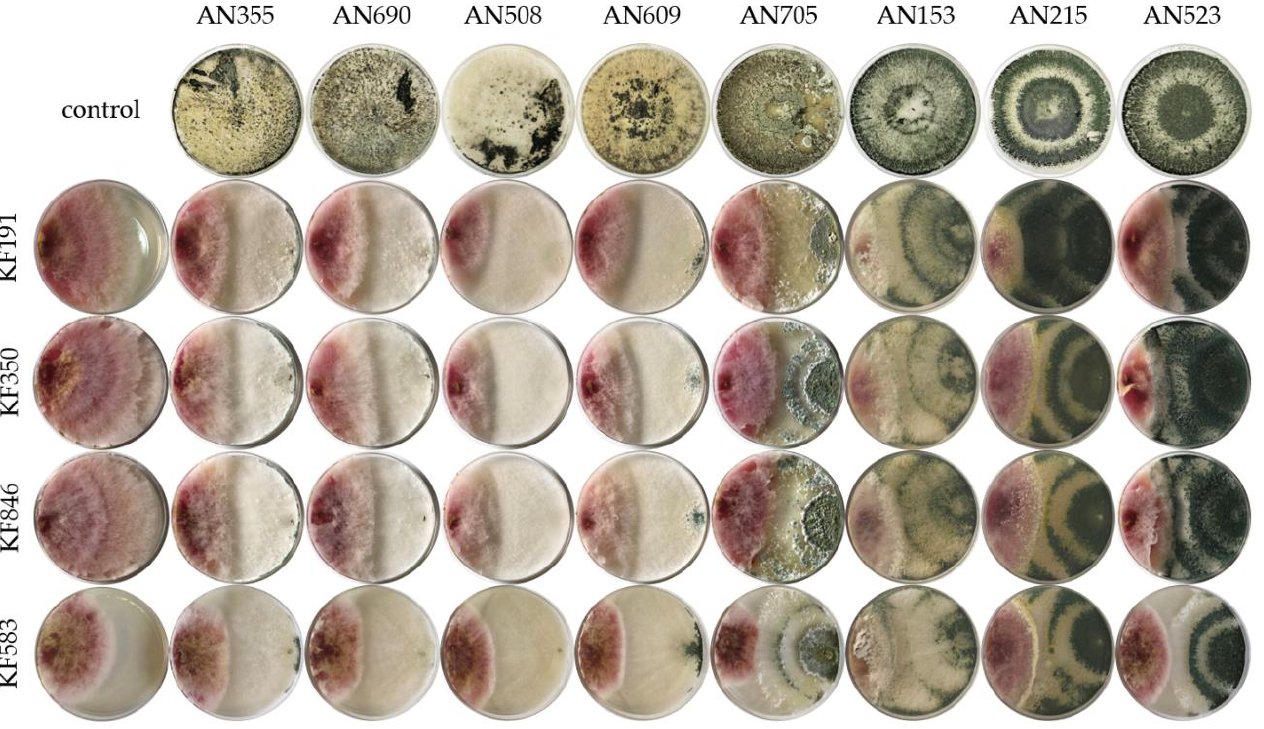
Figure 1. Fungal morphology of Fusarium in dual-culture assay on PDA after 5 days of incubation. F . culmorum KF191; F . culmorum KF350; F . culmorum KF846; F . cerealis KF583. Fusarium strain and Trichoderma strain grown alone-control, Fusarium strain with T . viride AN355, T . viride AN690, T . viridescens AN508, T . viridescens AN609, T . atroviride AN705, T . atroviride AN153, T . atroviride AN215, T . atroviride